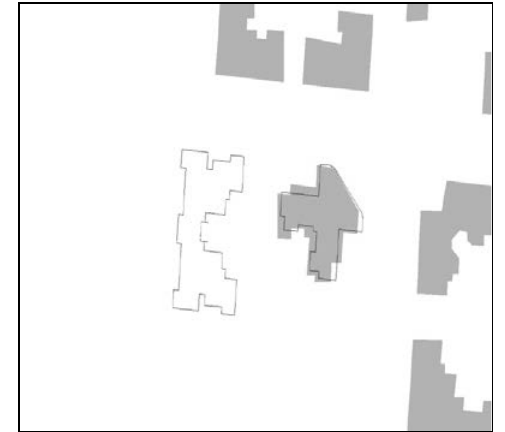
Figure 5: Full adjustment (1) and updating new data (2)